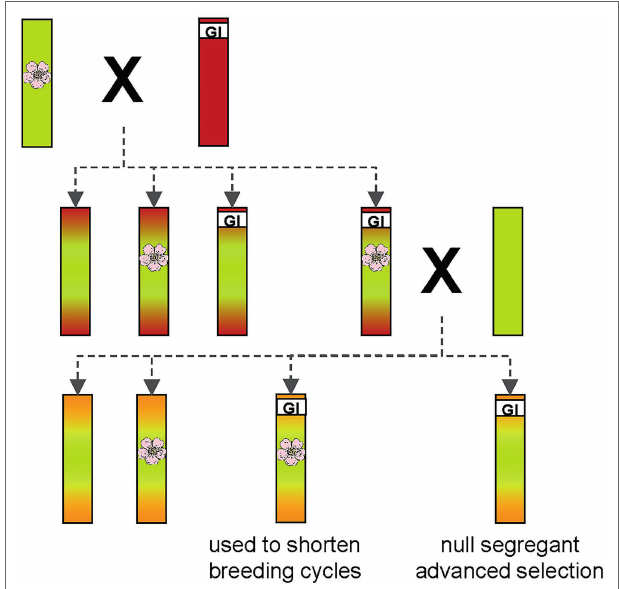
FIGURE 4 | Schematic representation of the idea behind the rapid cycle breeding program. One parent with excellent traits in terms of fruit quality (green) containing a transgenic T-DNA insertion for early flowering is crossed with another parent (red) containing a trait of interest, e.g., disease resistance. Many resistances are unfortunately only found in Malus wild species, which usually have insufficient fruit quality. The high proportion of adverse alleles in these genotypes is symbolized by the red color. Repeated backcrossing with high-quality apple varieties (green) gradually reduces the proportion of negative alleles. The flower symbolizes the transgene for early flowering. GI is the abbreviation for “gene of interest,” which confers the desired trait as, e.g., disease resistance. If both traits (early flowering and resistance) are inherited monogenically, a quarter of offspring will be produced with both traits. These genotypes can then be used in further crosses to shorten breeding cycles. Another quarter of offspring will contain only the gene of interest. Such non- transgenic null-segregants can be released from the breeding program as advanced